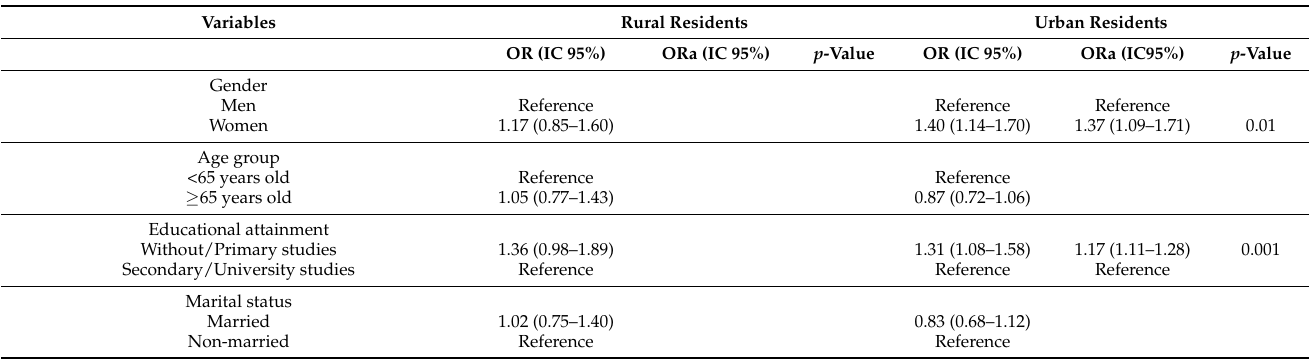
Table 2. Association between CMDs, sociodemographic factors and health-related determinants in rural and urban cancer patients ( n =